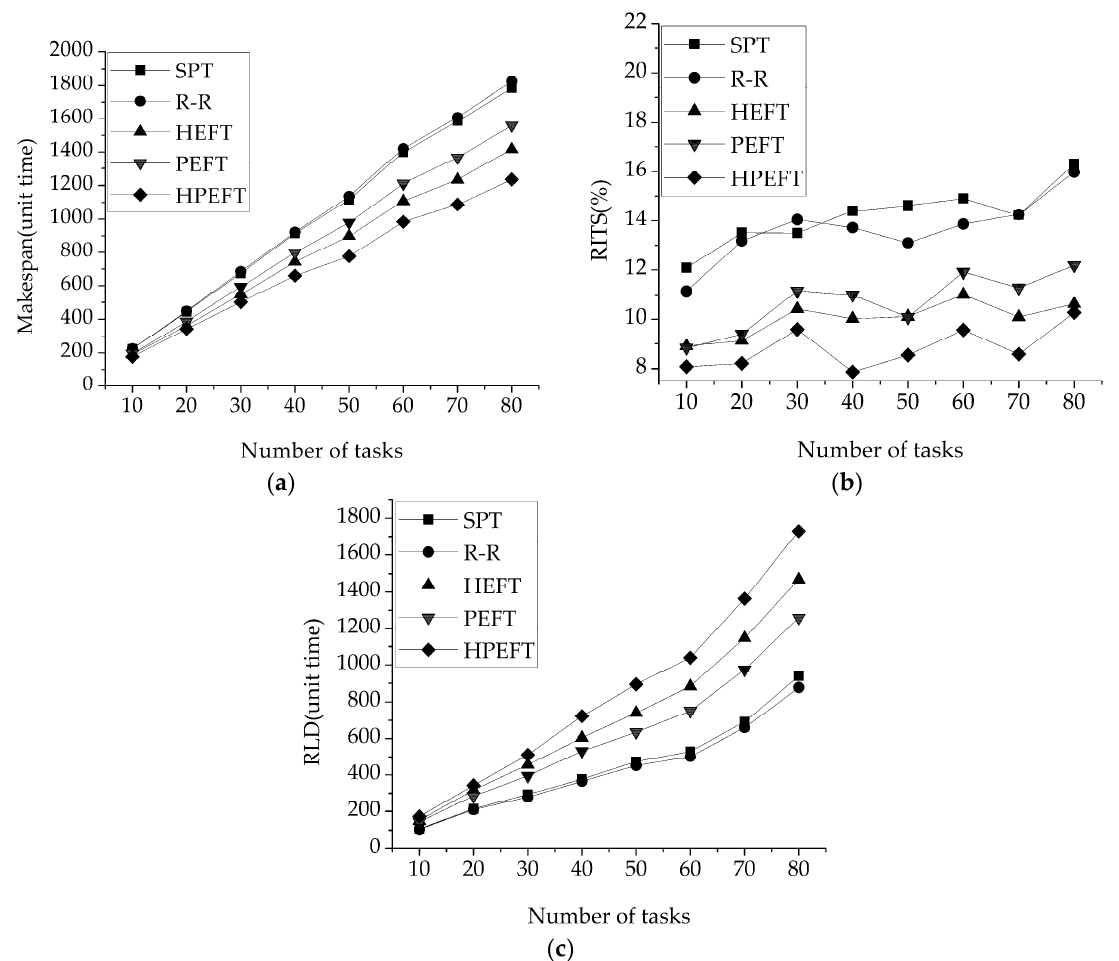
Figure 7. Variable number of tasks: ( a ) makespan, ( b ) RITS, and ( c ) RLD.